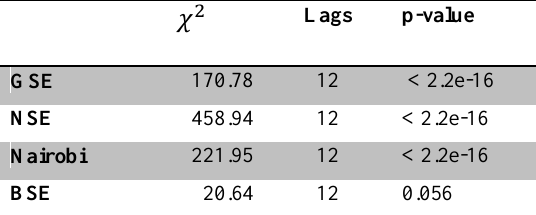
Table 3: Engle’s LM Test for (G)ARCH